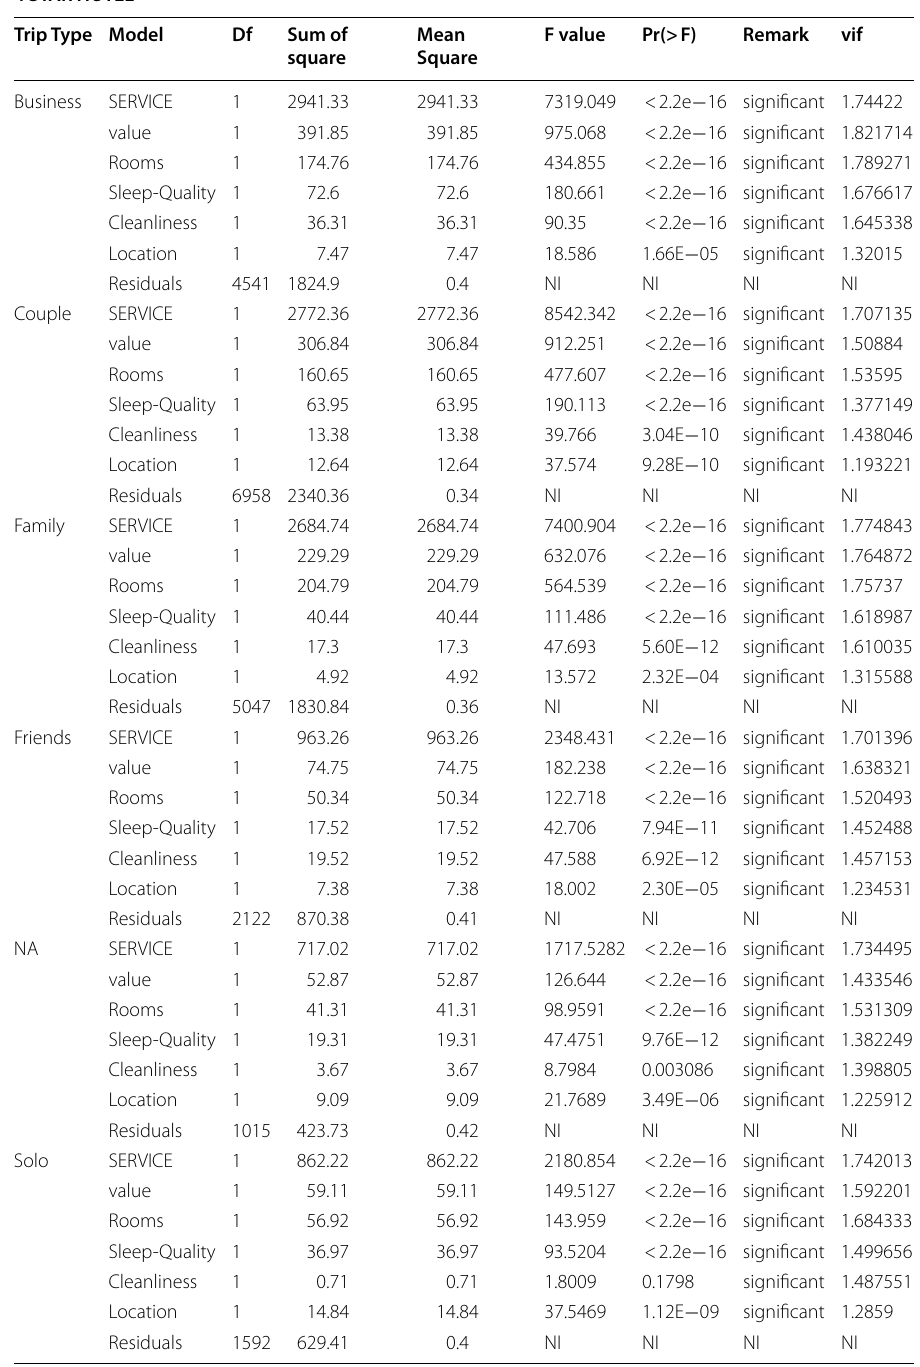
Table 10 Analysis of Variance of 4 star hotel class based on trip type 4 STAR